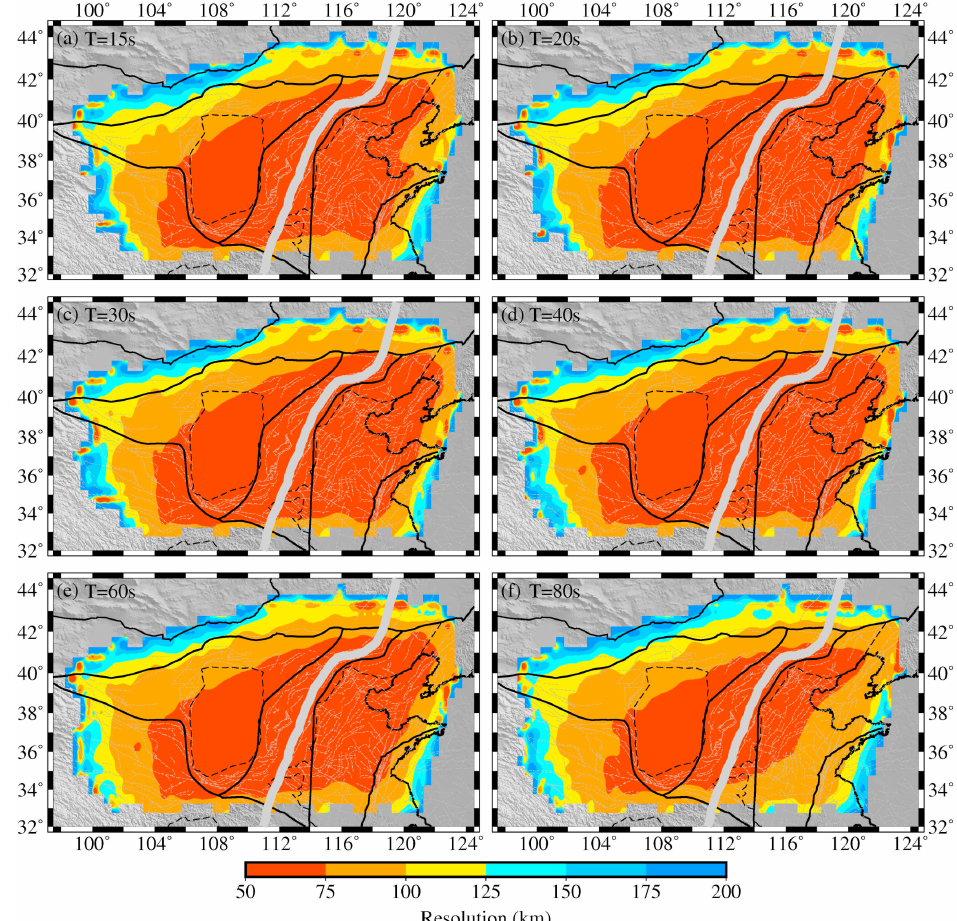
Figure 6. Resolution maps of Rayleigh wave tomography at periods of ( a ) 15, ( b ) 20, ( c ) 30, ( d ) 40, ( e ) 60 and ( f ) 80 s, respectively. We mask the area where the resolution is higher than 200